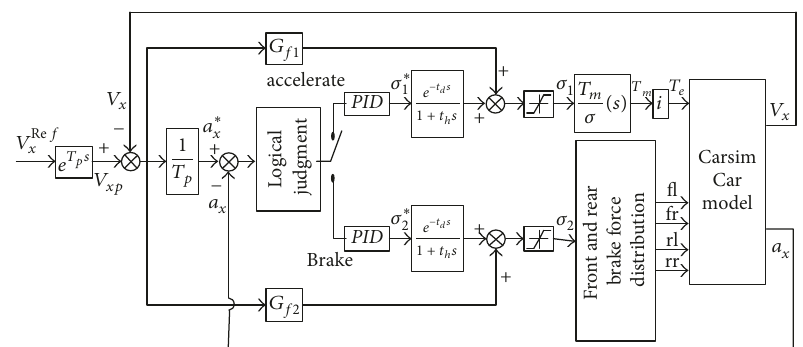
Figure 14: Longitudinal speed control strategy combined with feedforward-PID feedback.